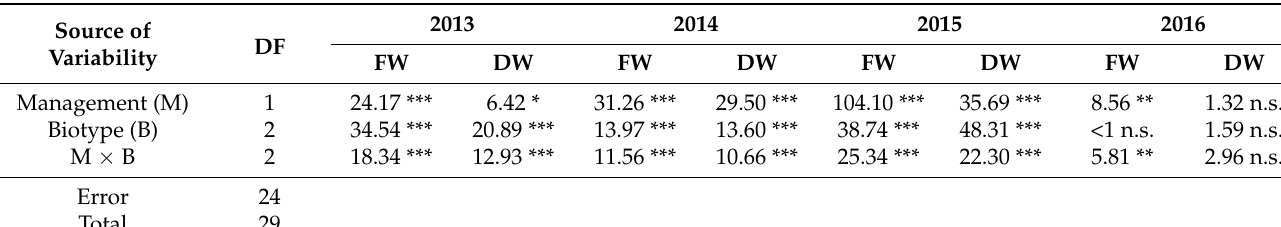
Table 4. Hypericum perforatum L. results of ANOVA ( F values) for the fresh and dry mass of flowers according to crop management (M) and biotype (B).